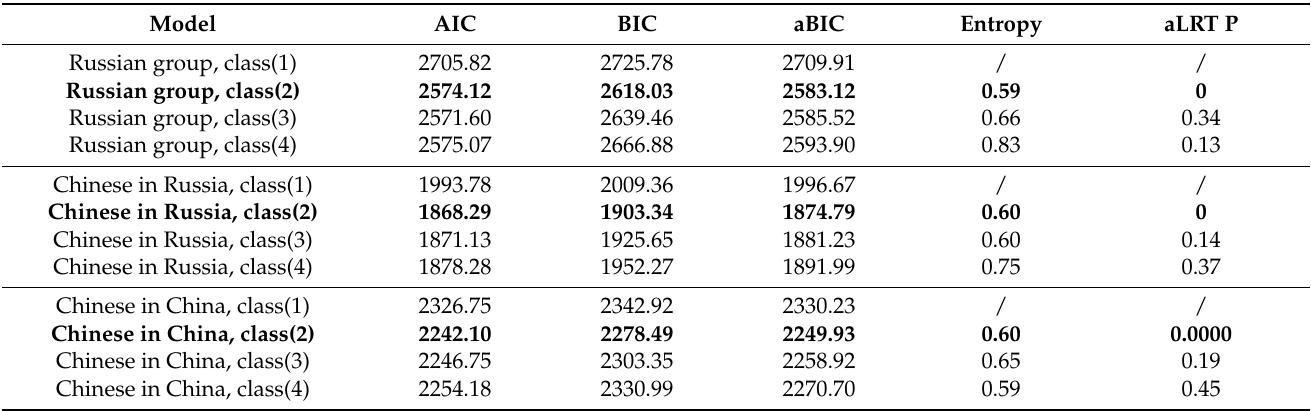
Table 2. Comparison of model fit indices for alternative LCA solutions in three groups. Model AIC BIC aBIC Entropy aLRT